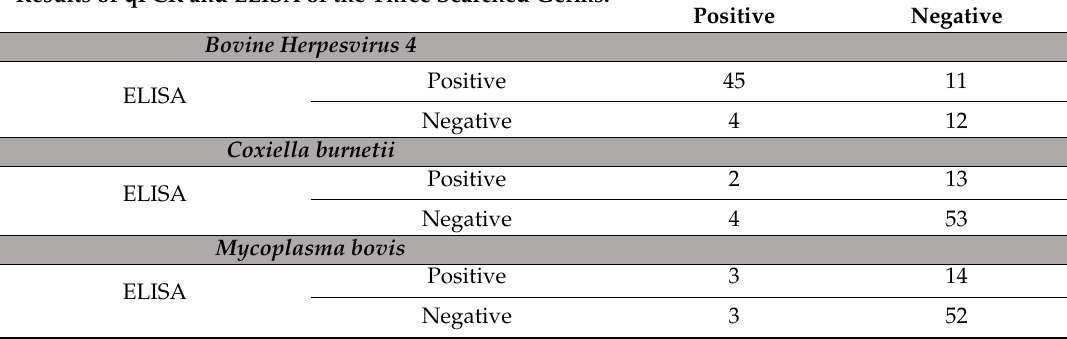
Table 1. Combined results of blood antibodies detected by ELISA and germs DNA identified by qPCR (peritoneal sample) for Bovine Herpesvirus 4, Coxiella burnetii and Mycoplasma bovis in 72 cows affected by parietal fibrinous peritonitis.